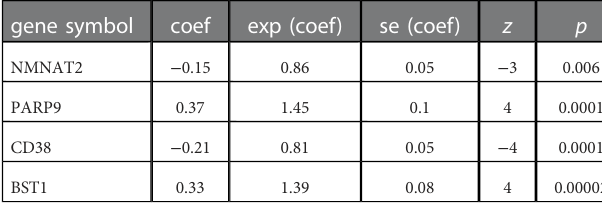
( Figure 10B ). Except for TIGIT, all the immune checkpoints were